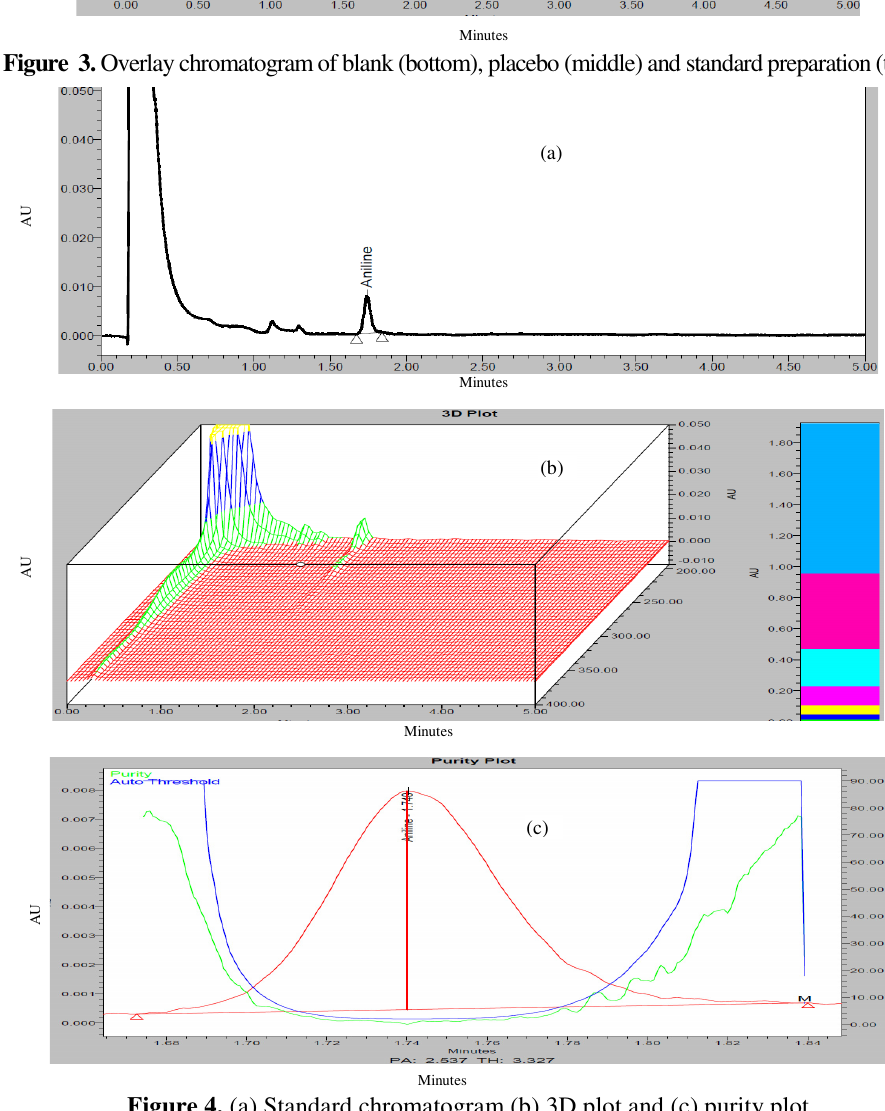
Figure 4. (a) Standard chromatogram (b) 3D plot and (c) purity